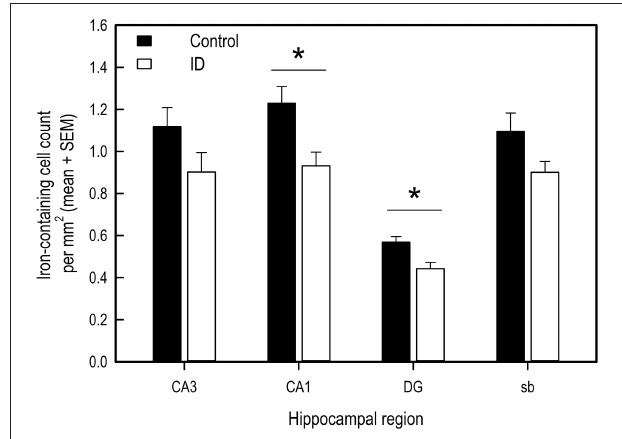
FIGURE 6 | Number of iron-containing cells in iron stained hippocampal sections of ID ( n = 8 ) and control ( n = 9 ) animals in hippocampal regions CA3, CA1, dentate gyrus (DG) and subiculum (sb) at 12 weeks of age. * p < 0.05 .